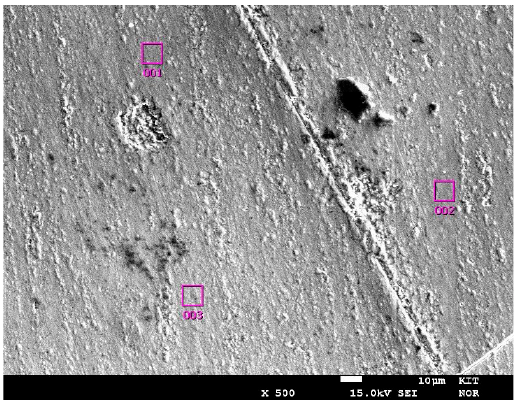
Figure 7. SEM of the flaking precipitations of the furnace (Figure 6b) with areas of interest. Table 9. Composition of precipitation (Figure 6, right ), determined by EDX. Elements marked with * were manually